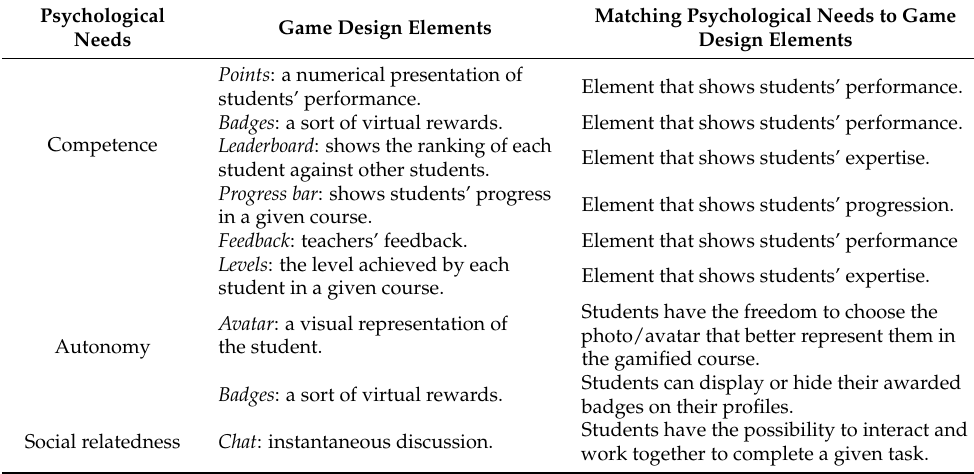
Matching Psychological Needs to Game Design